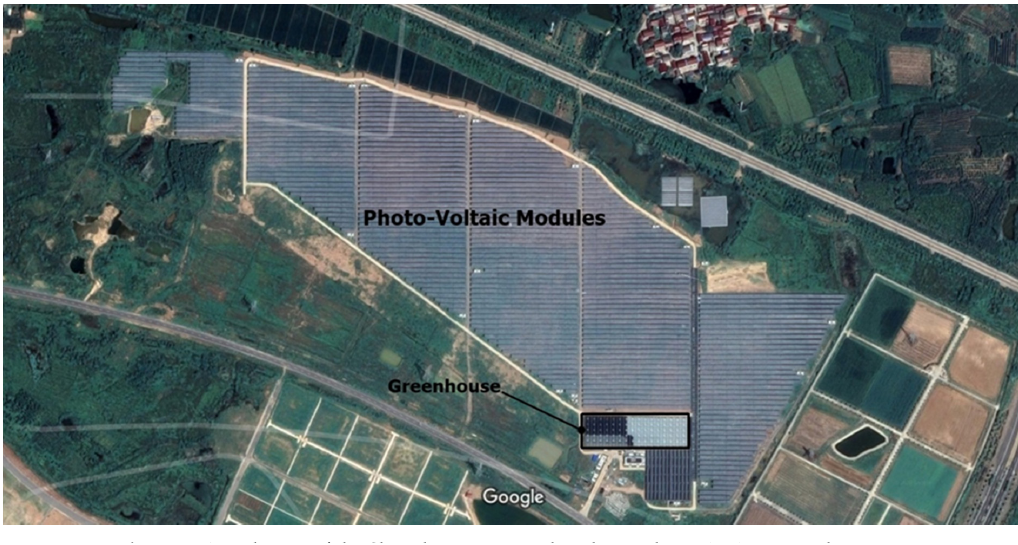
Figure 8. Aerial view of the Shenzhen Energy solar photovoltaics (PV) power plant [72]. The average monthly GHI for Baima is derived from the WorldClim dataset daily average GHI values and utilized to estimate the monthly potential electric generation power (potential GP), which is the technical solar potential of the land area occupied by the PV power plant. The estimated potential GP is thereafter illustrated alongside monthly actual electric generated power (actual GP) of the PV power plant for the years 2018 and 2019. The capacity of the solar PV plant was 19.05886 MW and 19.40606 MW in 2018 and 2019, respectively. A similar solar PV capacity is assumed. Despite this direct com- parison, it is noteworthy that there are many factors that influence the amount of electric power evacuated, including: sunshine hours, cloud cover, weather (rain, snow, etc.), solar cell efficiency and so forth. Figure 9 illustrates the estimated monthly potential GP and the monthly actual GP. Monthly sunshine hours derived from daily sunshine hour values recorded at the location of the plant are also illustrated as they have an influence on the amount of electric power generated.